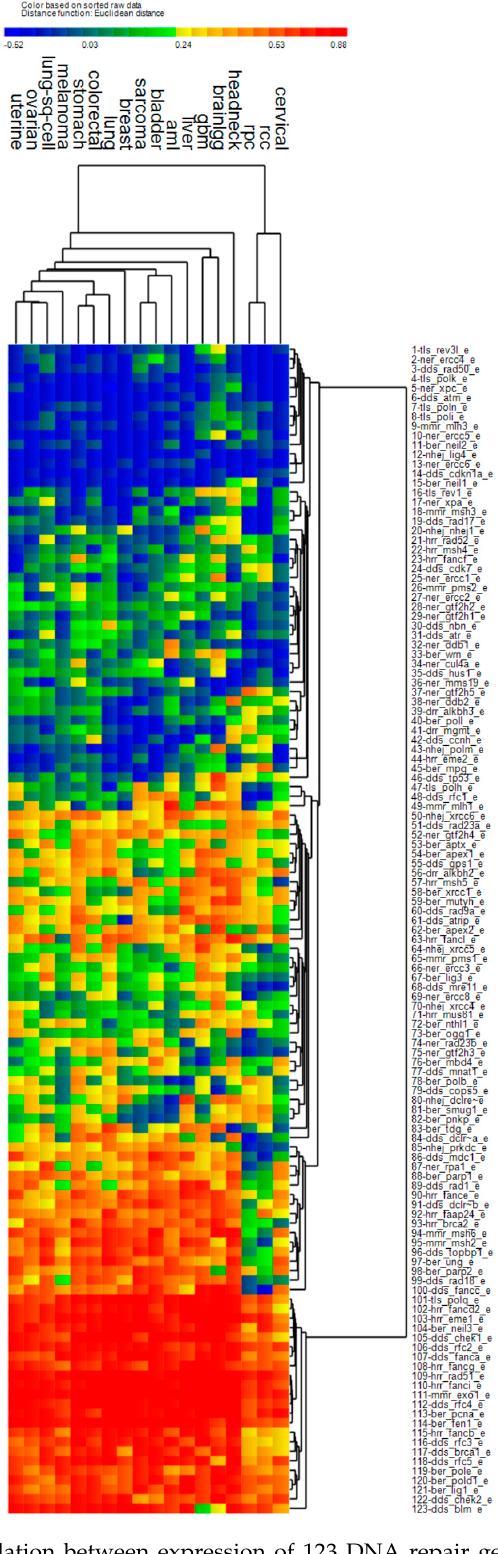
Figure 1. Pearson correlation between expression of 123 DNA repair genes (adjusted for age at diagnosis) and PCNA metagene expression (median expression of 131 genes correlated with PCNA ) within the 18 cancers considered. Heat map colors represent negative correlation (blue) and positive correlation (red). RCC: renal clear cell cancer; RPC: renal papillary cancer.